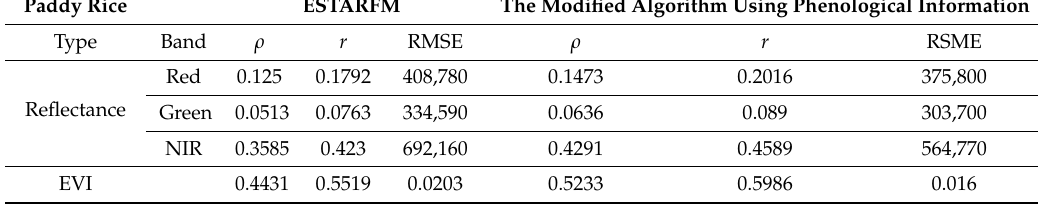
Table 4. Regression coefficient of the linear fitting equation, correlation coefficient, and root mean square error of reflectance and EVI of predicted reflectance compared with real reflectance for paddy